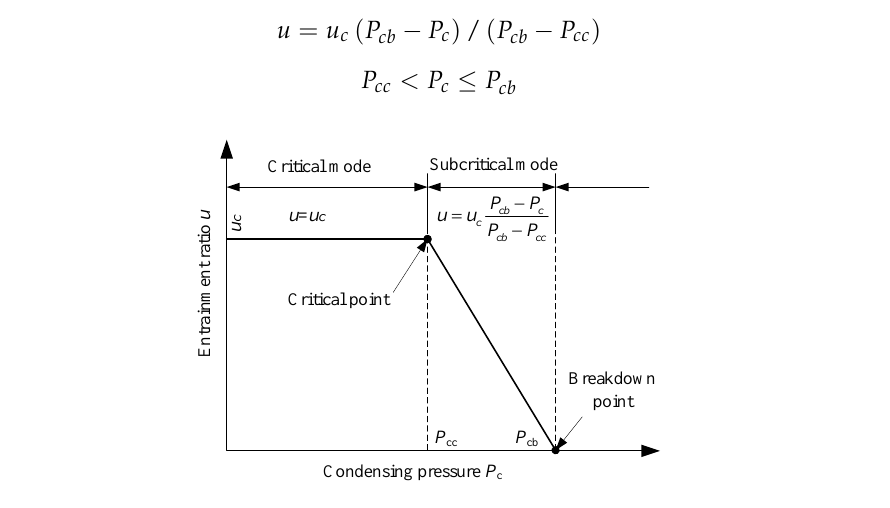
Figure 4. Operational modes of